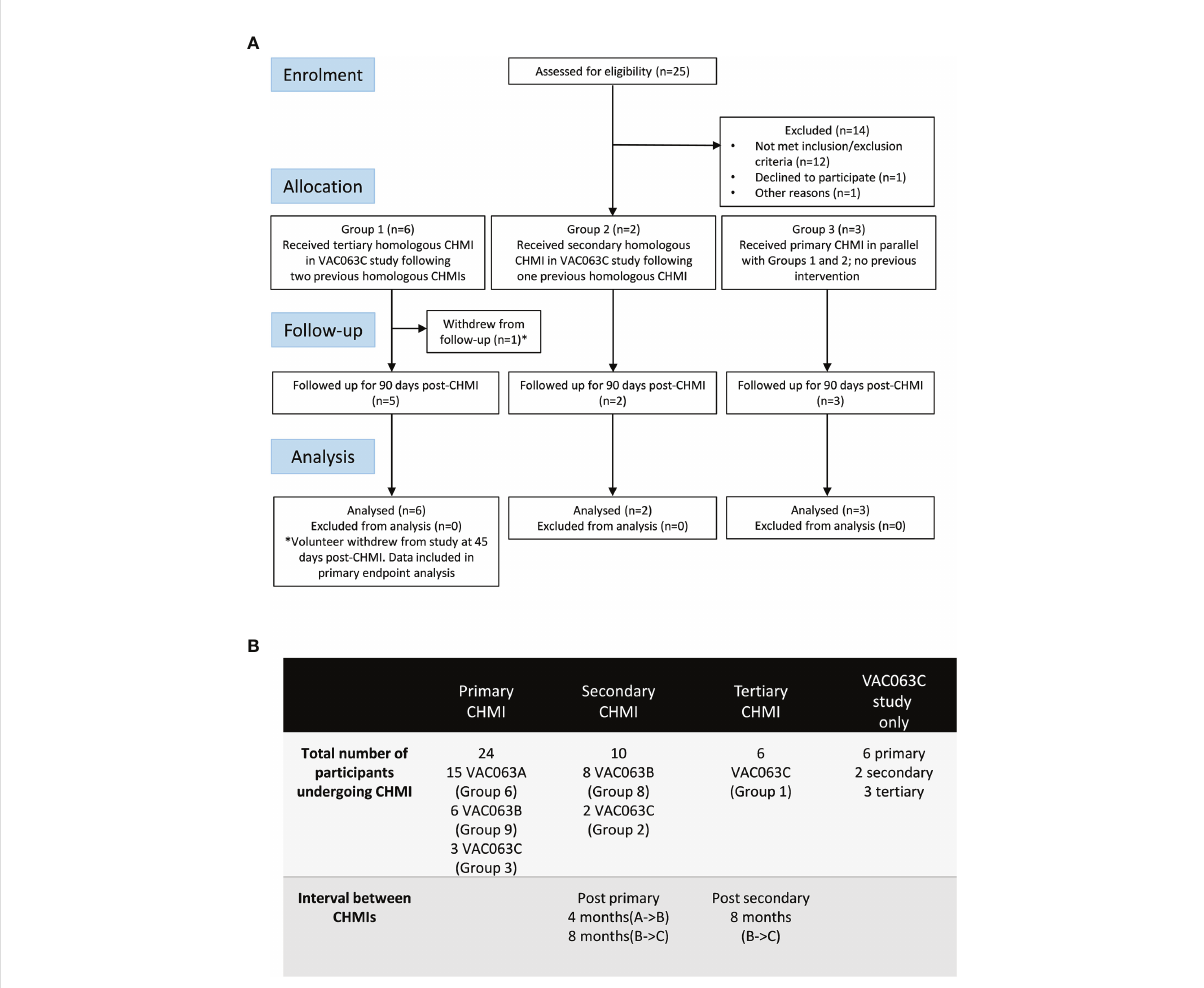
FIGURE 1 VAC063C fl ow chart of study design and volunteer recruitment. (A) Enrolment into the VAC063C study began in October 2018. Twenty fi ve volunteers were screened for eligibility. Eleven eligible volunteers were identi fi ed, six of whom were VAC063 participants returning for a tertiary controlled human malaria infection (CHMI) (Group 1), two of whom were VAC063 participants returning for a secondary CHMI (Group 2) and three of whom were newly enrolled participants for primary CHMI (Group 3). Clinical follow-up continued until 90 days after challenge (C+90) and was completed by 14 th January 2019. Volunteer demographics are summarized in Table S1. (B) In total (across three CHMI studies, VAC063A, B and C) 24 participants underwent primary CHMI, 10 of whom subsequently underwent secondary CHMI and six of those participants returned for a tertiary CHMI. The fi rst CHMI (VAC063A) was on 14 th November 2017, the second (VAC063B) was on 6 th March 2018 and the third (VAC063C) was on 6 th November